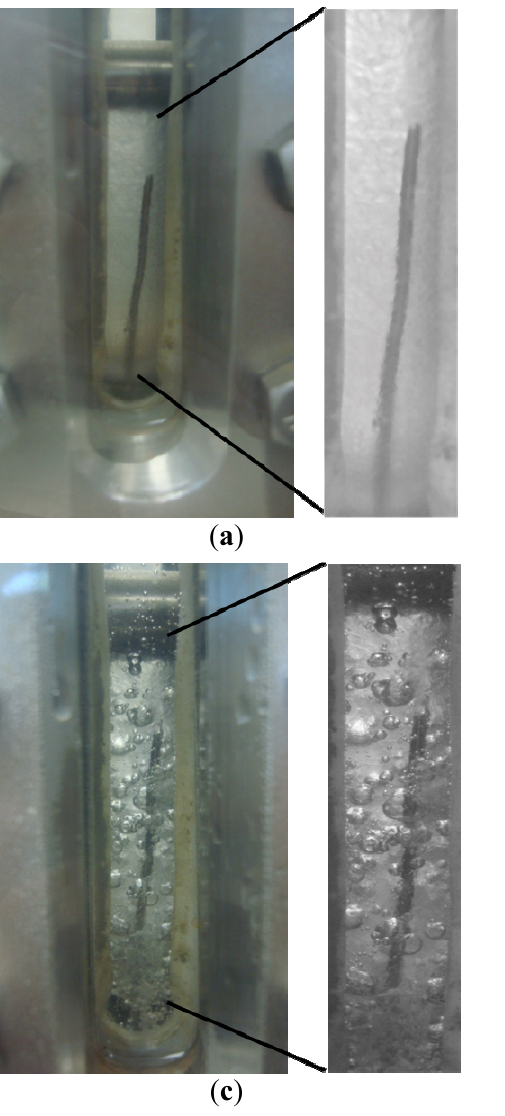
Figure 6. Time resolved visual observations of the CO ( a ) 339 psig, 5.46 °C; ( b ) 369 psig, 1.62 °C; ( c ) 428 psig, 12.98 °C; ( d ) 508 psig, 15.28 °C. These letters correspond to the numbered P/T conditions shown in the dissociation plot of Figure 5 where point 1 in Figure 5 represents (a) shown below. CO 1.1 g/cc) were observed to have an ice-like appearance in the aqueous phase at temperatures above the freezing point of a water-SDS